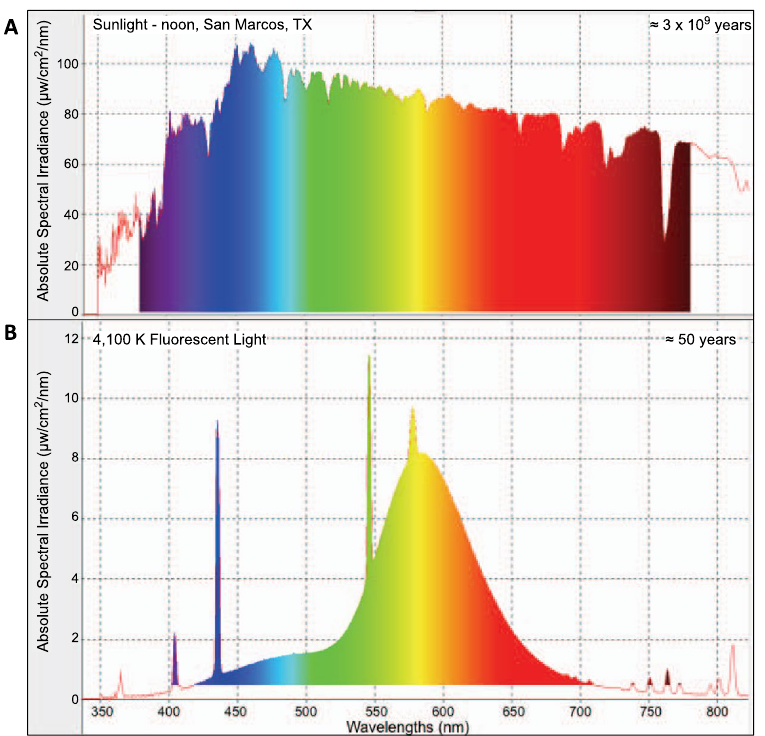
Figure 1. Spectral distribution of natural sunlight in San Marcos, TX at noon (top, A ) and Phillips 4100 K cool white bulbs used for the FL exposures (bottom, B